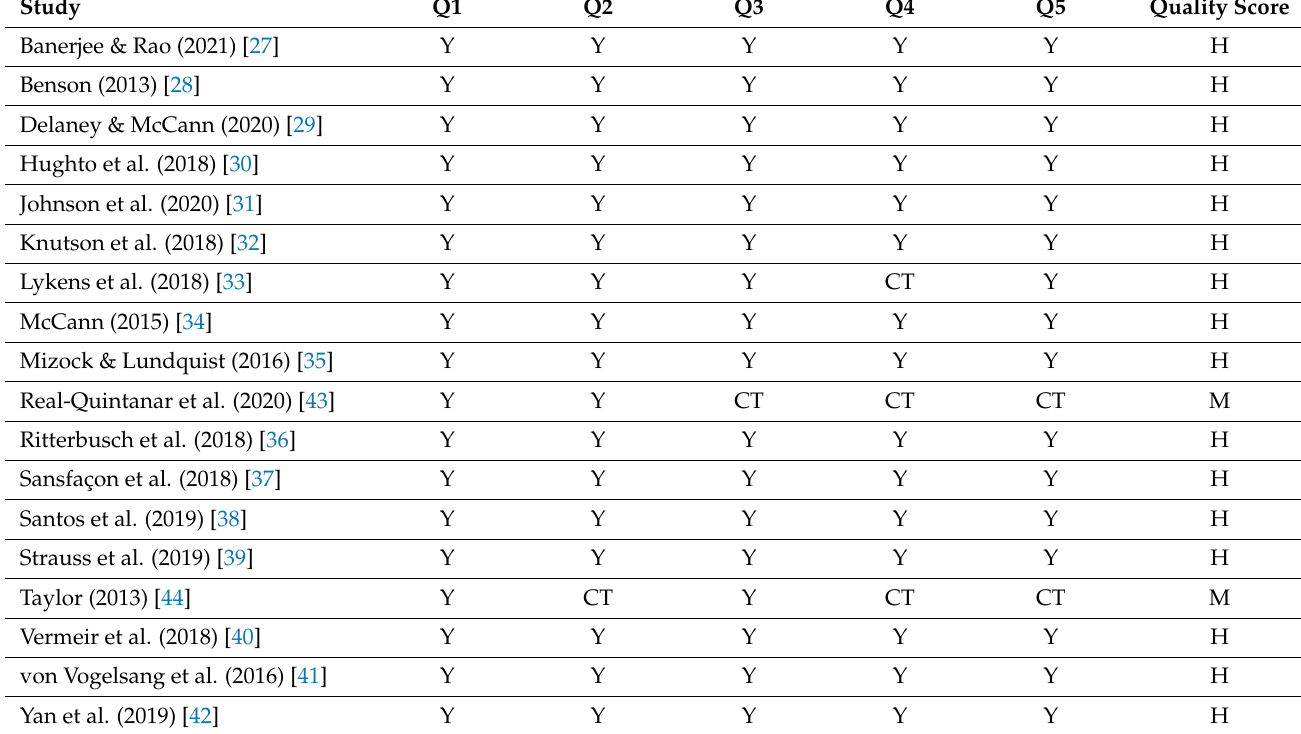
Table 2. Methodological quality of qualitative studies using MMAT (Hong et al.